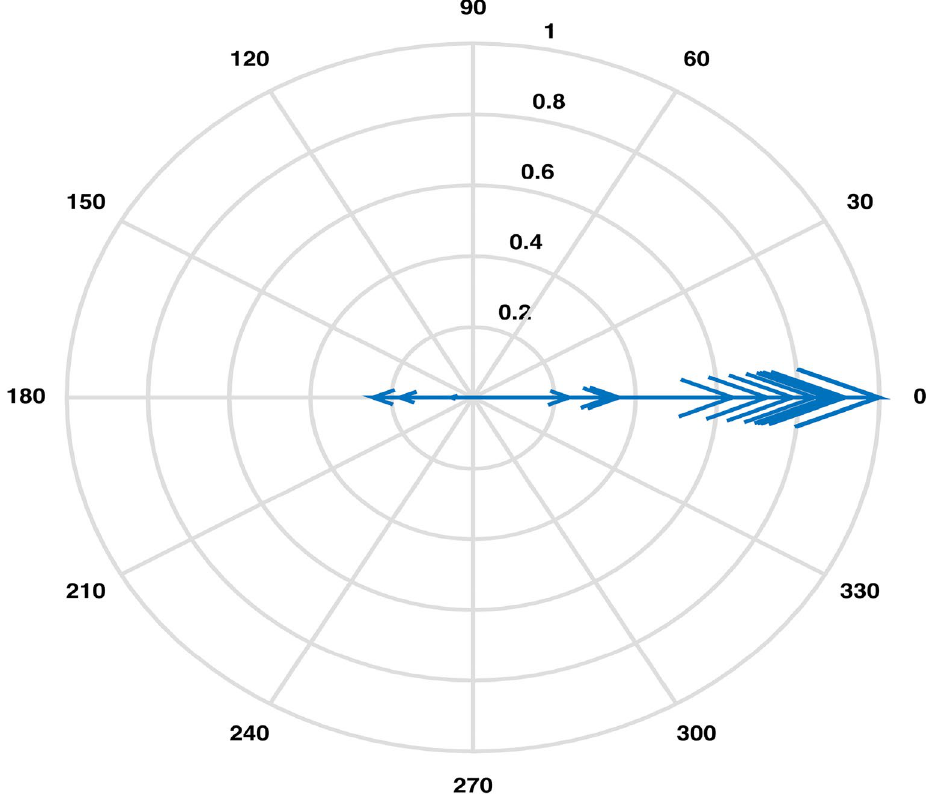
Figure 5. Pairwise correlations of EC with other